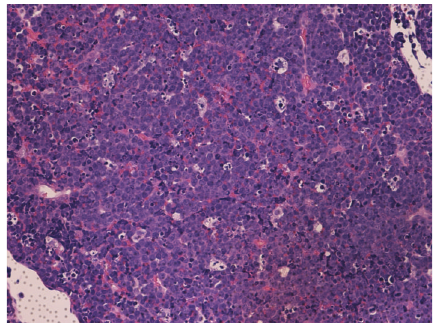
Figure 7: 20 × power H&E stain jaw biopsy. Diffuse infiltrate of medium to large lymphoid cells that are monomorphic against a heavy background of scattered macrophages with a “starry sky” pattern, in keeping with Burkitt’s